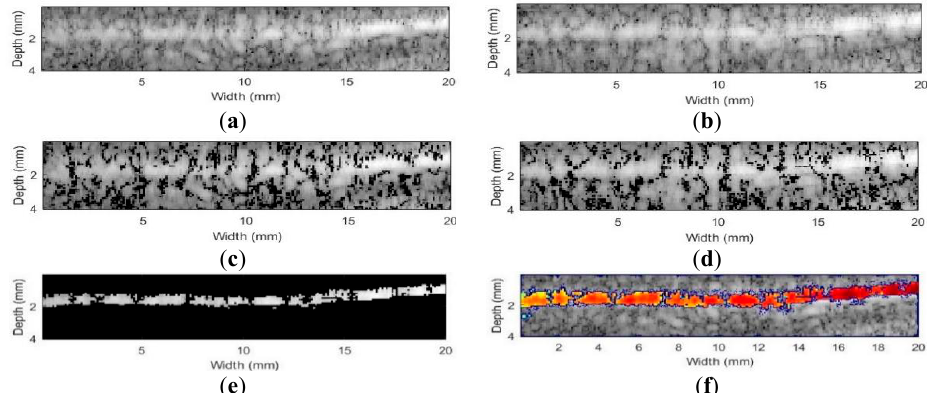
Figure 13. The image result of ear vein: ( a ) DAS; ( b ) MV; ( c ) ESBMV; ( d ) BWT; ( e ) bubble region detection; and ( f ) UCA-enhanced image.